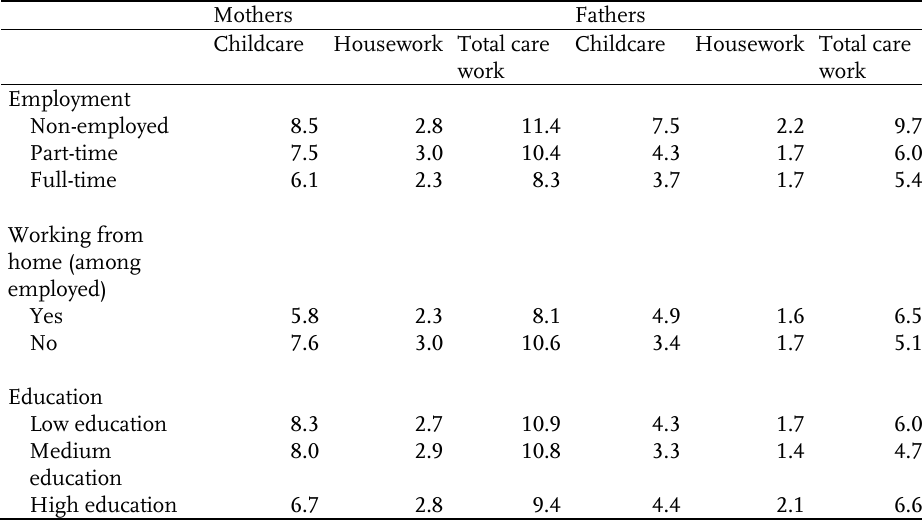
Table 3 : Mean hours per weekday spent on childcare, housework and total care work by Mothers Fathers Childcare